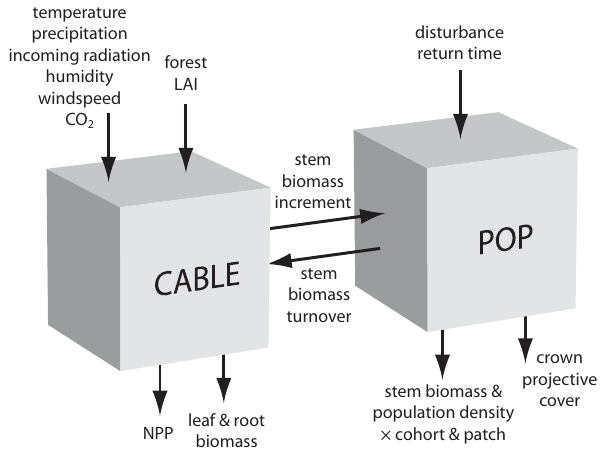
Figure 1. Coupling of CABLE and POP, along with key inputs and